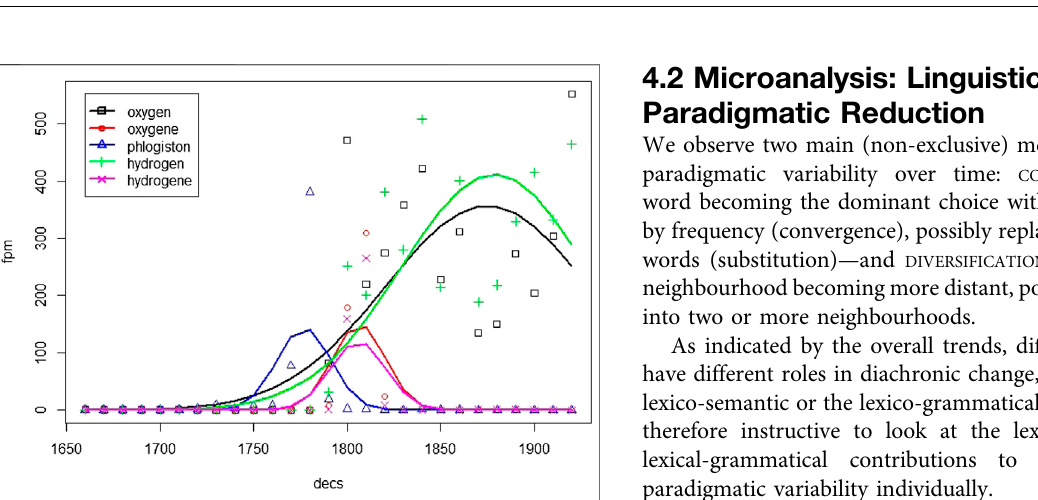
FIGURE5| Diachronictrendsofnouns(NN)vs.verbalpartsofspeech(VVG,VVD,VVN)intermsof (A) MeanDistance(mdist)and (B) ParadigmaticVariability(pvar) by decade.